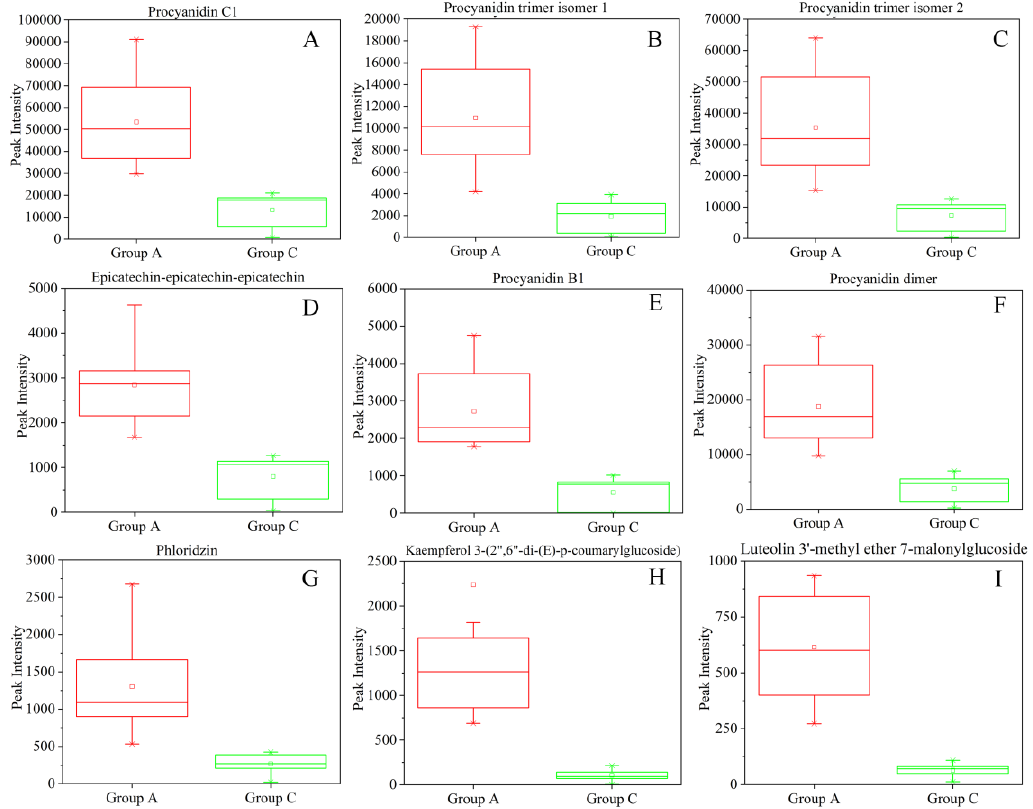
Figure 4. Boxplots of relative peak intensities of nine marker compounds distinguish peach cultivars with high (group A) and low (group C) alpha-glucosidase inhibitory activity. ( A ), Procyanidin C1; ( B ), Procyanidin trimer isomer 1; ( C ), Procyanidin trimer isomer 2; ( D ), Epicatechin-epicatechin-epicatechin; ( E ), Procyanidin B1; ( F ), Procyanidin dimer; ( G ), Phloridzin; ( H ), Kaempferol 3-(2”,6”-di-(E)-p-coumarylglucoside); ( I ), Luteolin 3’-methyl ether 7-malonylglucoside.